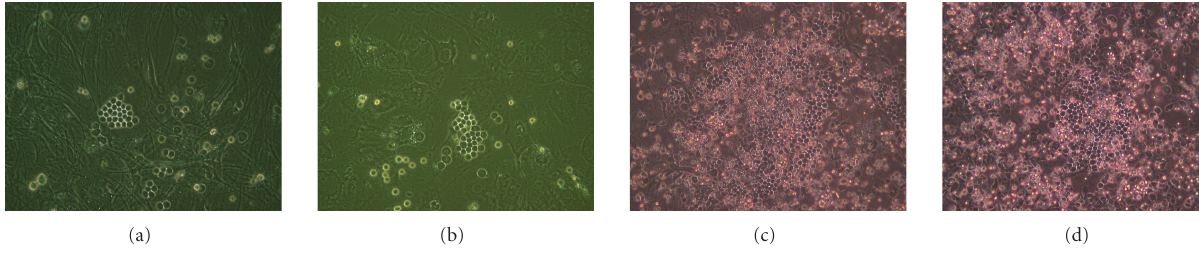
Figure 1: Appearance of the cells attached to feeder cells. Representative examples of CD34(+) human hematopoietic stem/progenitor cells cultured on either OP9 feeder cells ((a), (c)) or C3H10T1/2 feeder cells ((b), (d)) for 7 days ((a), (b)) or 22 days ((c), (d)).